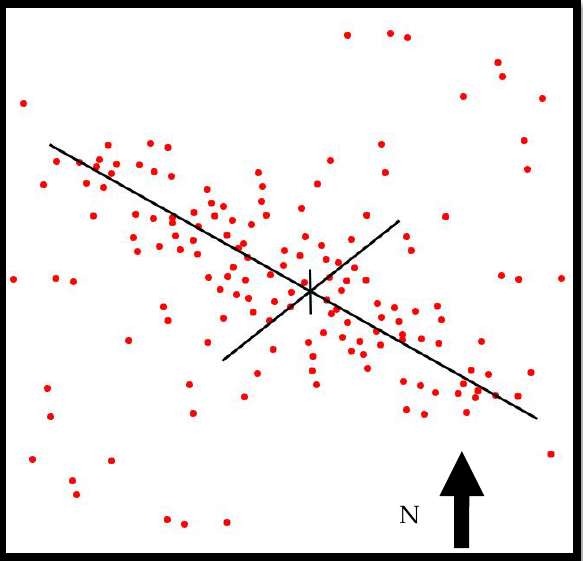
Figure 6. Fry analysis related to copper mineralization dispersion in the study area.